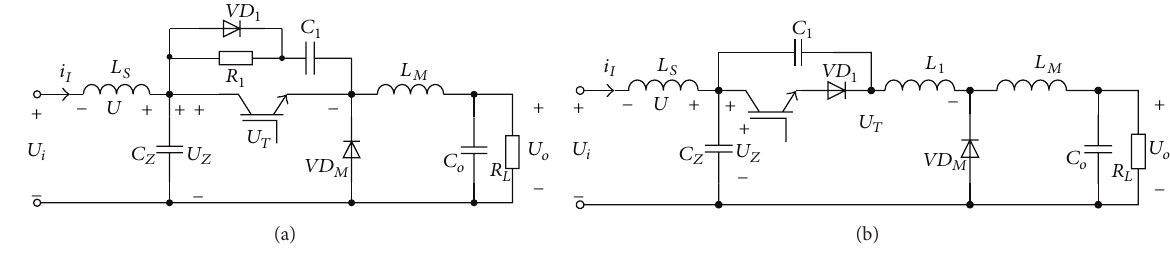
Figure 9: The improved Buck converter topological